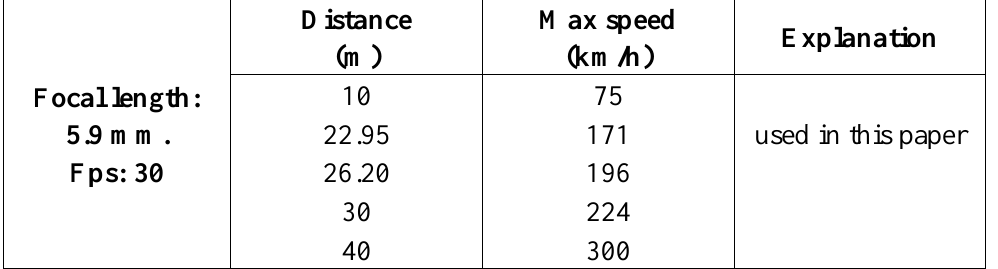
Table 3. Camera to object distance and maximum speed that can be